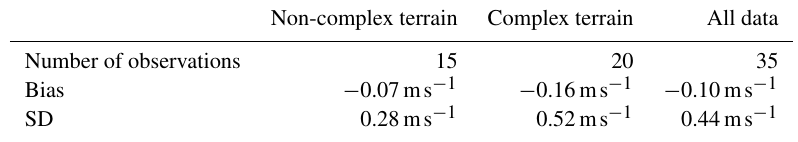
Table 1. Validation statistics for the baseline assessment of ME-WAM without MTLA applied for a sample of 35 data points.